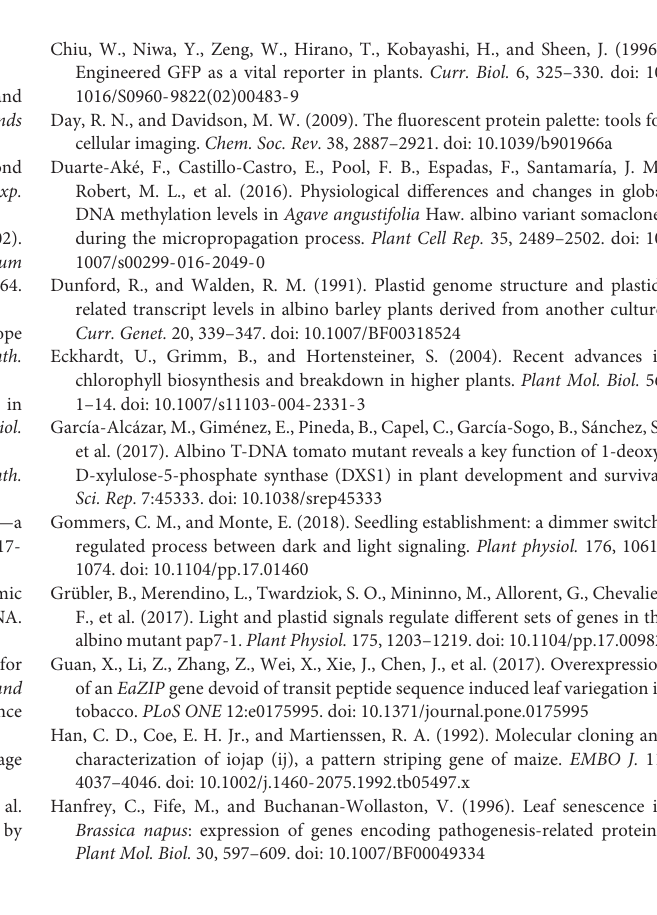
Supplementary Figure 1 | Sequence alignment of the cDNAs of EaZIP (without cTP) (Accession #: FJ666046) and Arabidopsis CHL27 (Accession #: